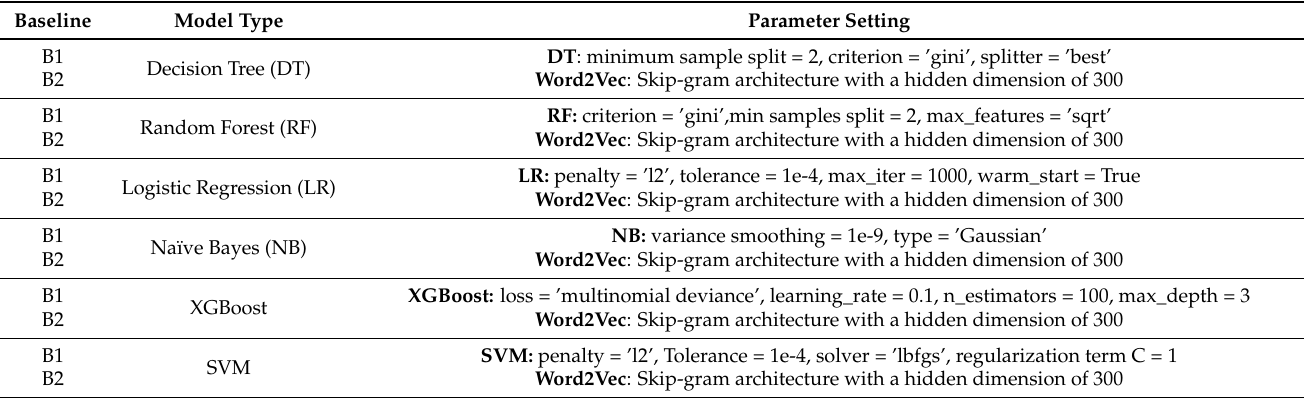
Table A1. Hyperparameter settings for baseline